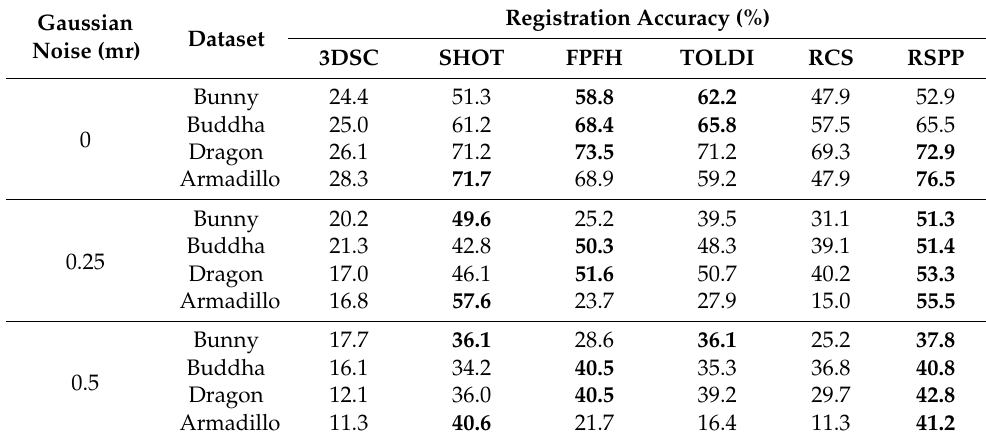
Figure 10. RP curves of different feature descriptors under 0.5 mr Gaussian noise: ( a ) RP curve of Bunny dataset; ( b ) RP curve of Buddha dataset; ( c ) RP curve of Dragon dataset; ( d ) RP curve of Armadillo dataset. Table 6. Registration accuracy of different feature